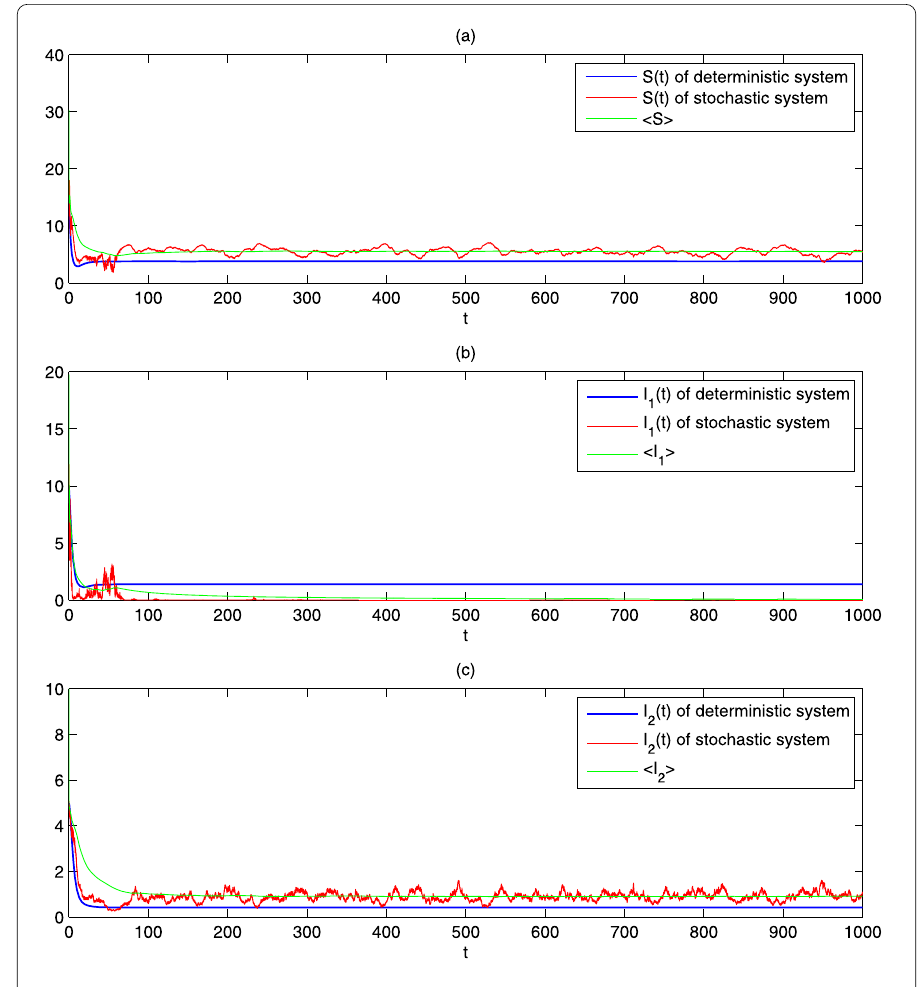
Figure 5 Dynamic behaviour comparisons of S ( t ), I 1 ( t ), I 2 ( t ) in the deterministic and the stochastic SIS system with parameters A = 1, d = 0.1, β 1 = 1.2, β 2 = 1.5, a 1 = 1, a 2 = 1.5, b 1 = 2, b 2 = 1, α 1 = 0.2, α 2 = 0.4, r 1 = 0.3, r 2 = 0.3, σ 1 = 1.1, σ 2 = 0.2. (a) Time series for S ( t ) and (cid:5) S ( t ) (cid:6) . (b) Time series for I 1 ( t ) and (cid:5) I (cid:6) . (c) Time series for I (cid:5) I (cid:6) 1 ( t ) 2 ( t ) and 2 ( t )